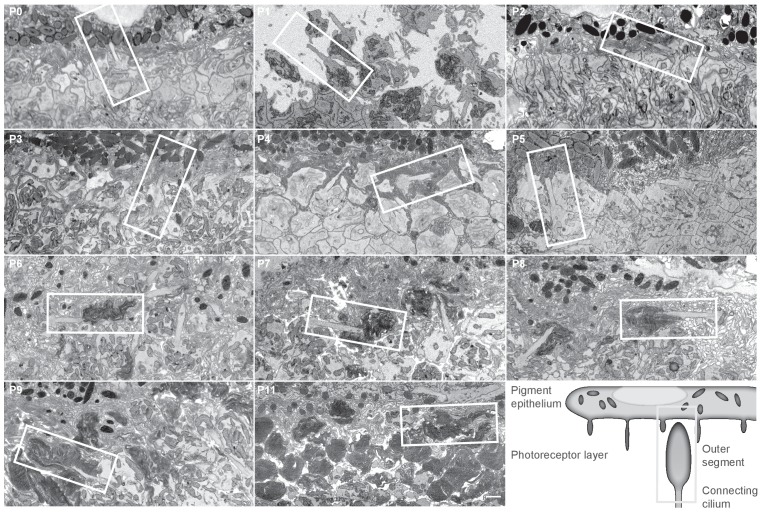
The ultrastructure of photoreceptors at different postnatal days.Each panel shows a single image from a serial block-face electron microscopy image stack at the indicated postnatal day. Pigment epithelium is attached at all time points except P1. Scale bar 1 μm. The white boxes indicate regions that are shown in Figure 1A.